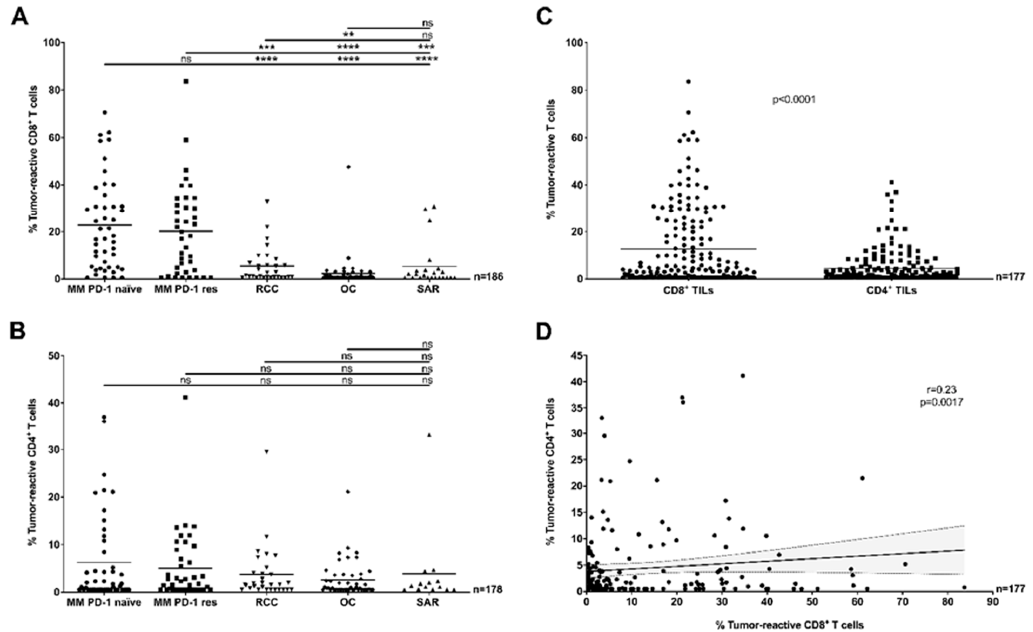
Figure 1. Antitumor-reactivity of tumor-infiltrating lymphocytes (TILs) across clinical cohorts and TIL sub-populations (in vitro, pooled data). ( A ) The proportion of tumor-reactive CD8 + TILs was significantly greater in Metastatic Melanoma (MM) cohorts compared to other tumor types, with no difference related to previous exposure to anti-PD-1 therapy (Mann–Whitney U test, p < 0.001). ( B ) The proportion of tumor-reactive CD4 + TILs was similar across all clinical cohorts (Mann–Whitney test, p > 0.05). ( C ) Comparing TIL subpopulations demonstrated that a greater proportion of CD8 + TILs were tumor-reactive compared to CD4 + TILs (Mann–Whitney test p < 0.0001, pooled clinical cohorts). ( D ) The proportion of tumor-reactive CD8 + TILs was only weakly correlated (Spearman r = 0.23, p = 0.0017) to the proportion of tumor-reactive CD4 + TILs in the same samples (pooled clinical cohorts). The solid line and dotted lines represent the best-fit regression line and 95% confidence interval, respectively. ( A – D ) In all panels, the recognition of TILs (Young TILs (Y TILs) and Rapidly Expanded TILs (REP TILs)) was tested against separate sets of autologous tumor cells (tumor cell lines (TCLs), TCLs + interferon gamma (IFN γ ) or fresh tumor digests (FTDs)) and only the highest value reported. T cells were considered reactive if positive for at least one of TNF, IFN γ or CD107a, minus control. ** p < 0.01, *** p < 0.001, **** p < 0.0001, ns: no statistical